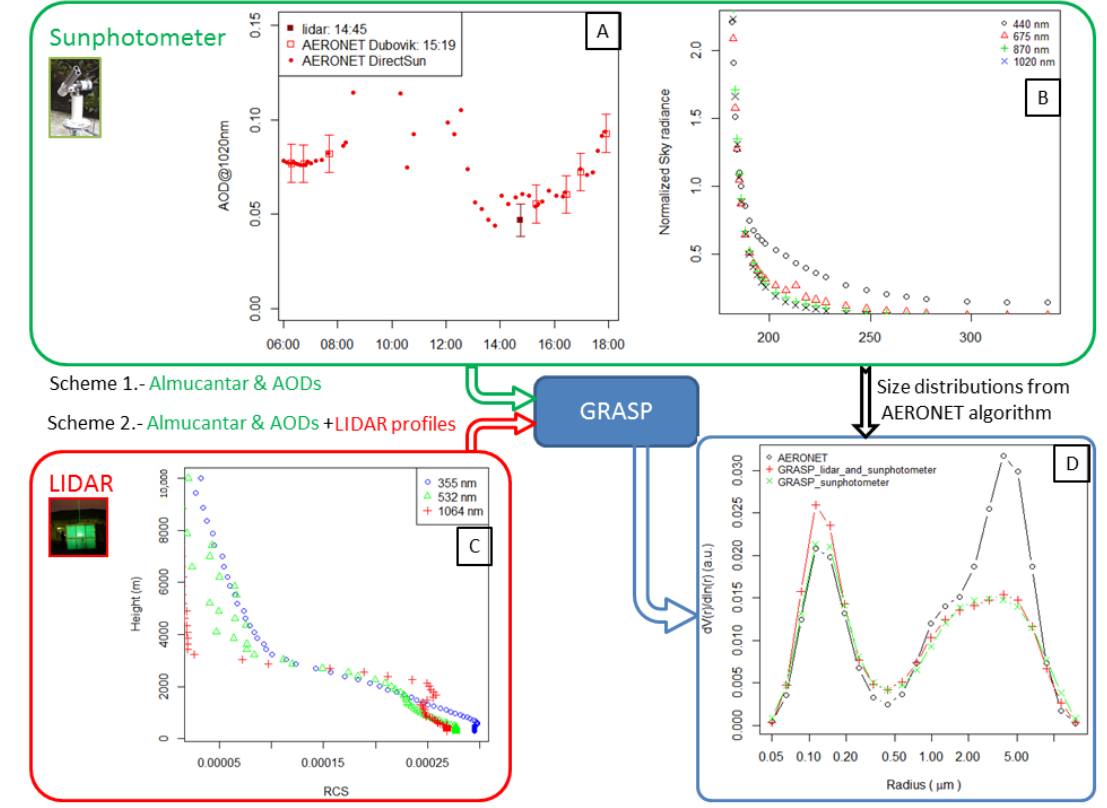
Figure 2. Schematic representation of the two procedures. ( a , b ) show the products provided by the sunphotometer (AOD @ 1020 nm values and almucantar sky radiances) and ( c ) the vertical range-corrected lidar profiles in GRASP format. The retrieved VSDs are shown in ( d